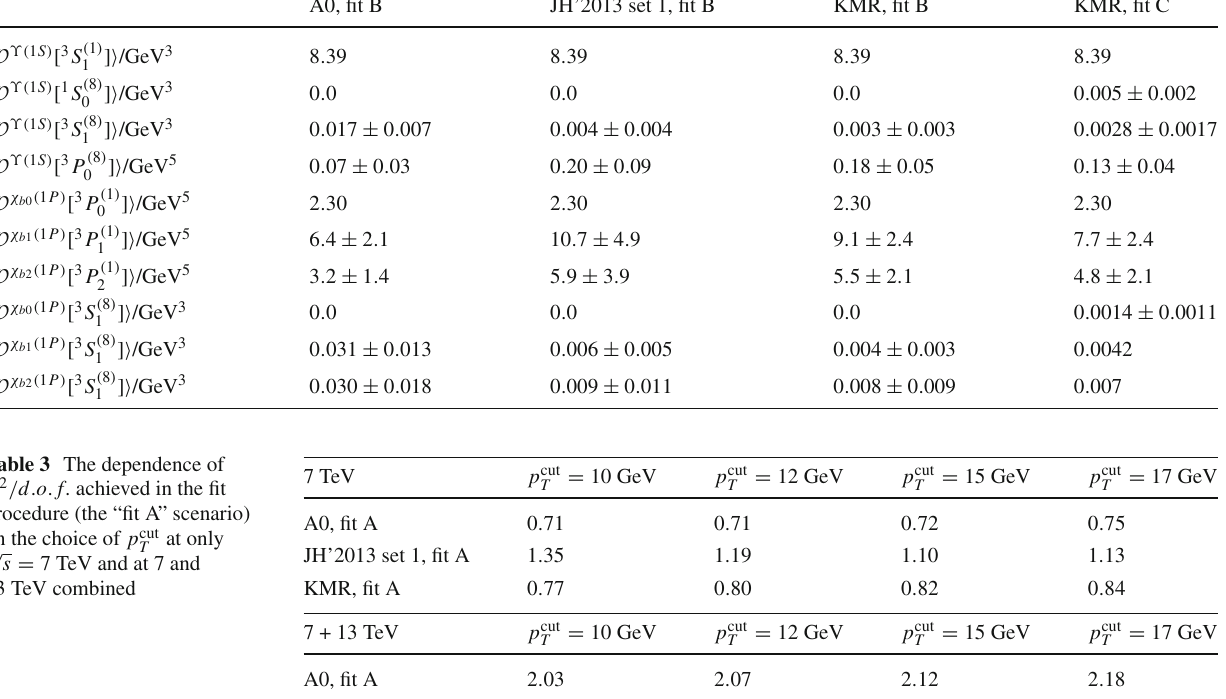
Table 2 The NMEs for the ϒ( 1 S ) and χ b ( 1 P ) mesons as determined from our fit at p cut = 0 GeV (the “fit C” scenario) density at p cut T